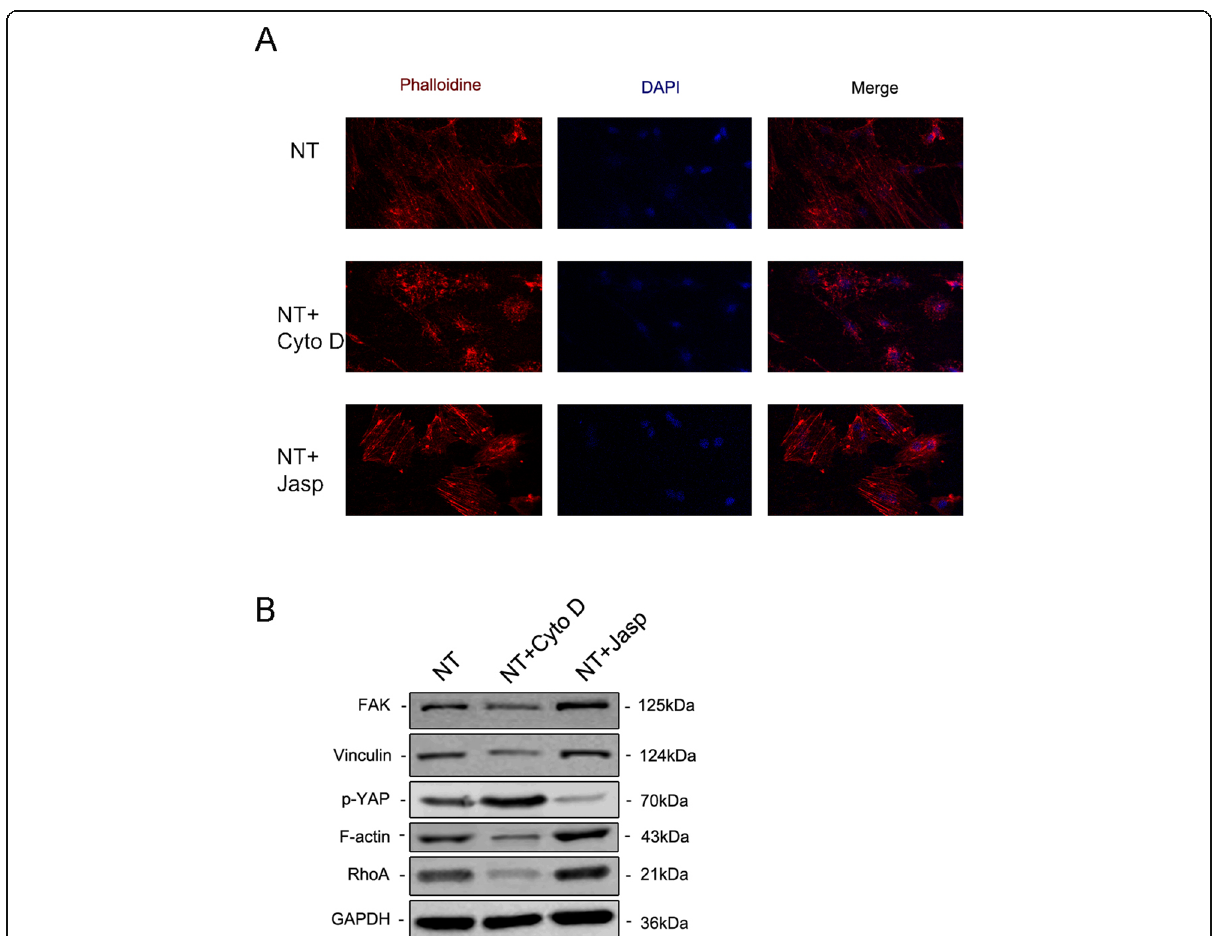
Fig. 5 Immunofluorescence staining revealed the level of F-actin by staining with rhodamine-conjugated phalloidin ( a ). The protein expression of FAK and VCL contained in the focal adhesion complex, RhoA and phosphorylated YAP were investigated by Western blotting ( b ). NT the nanotubes